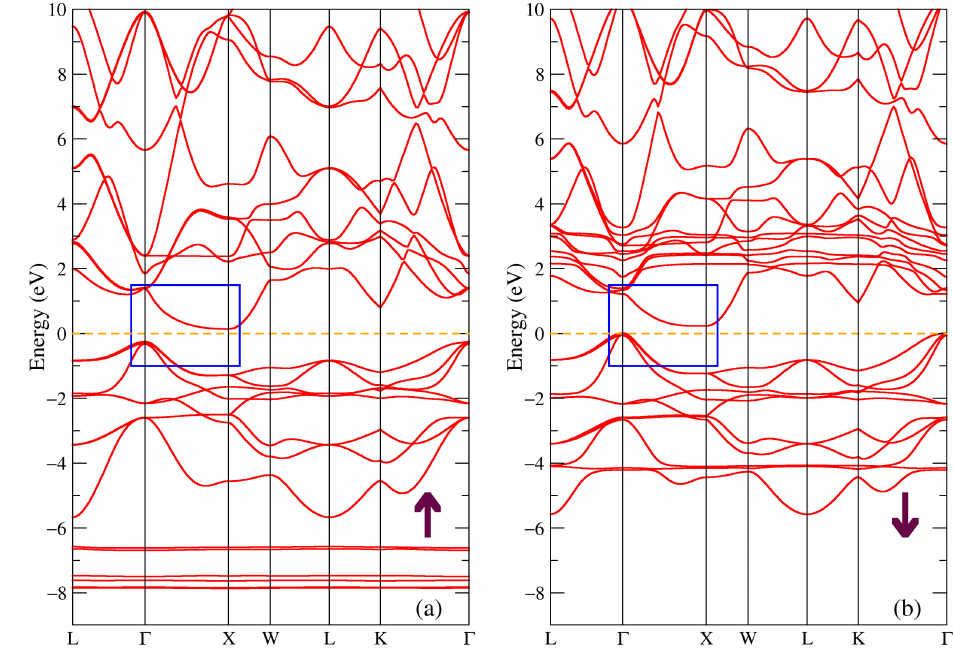
Figure 6. Band structure of DyNiSb: ( a ) majority and ( b ) minority spin projections. The blue rectangle points out the bands involved in the band gap formation.